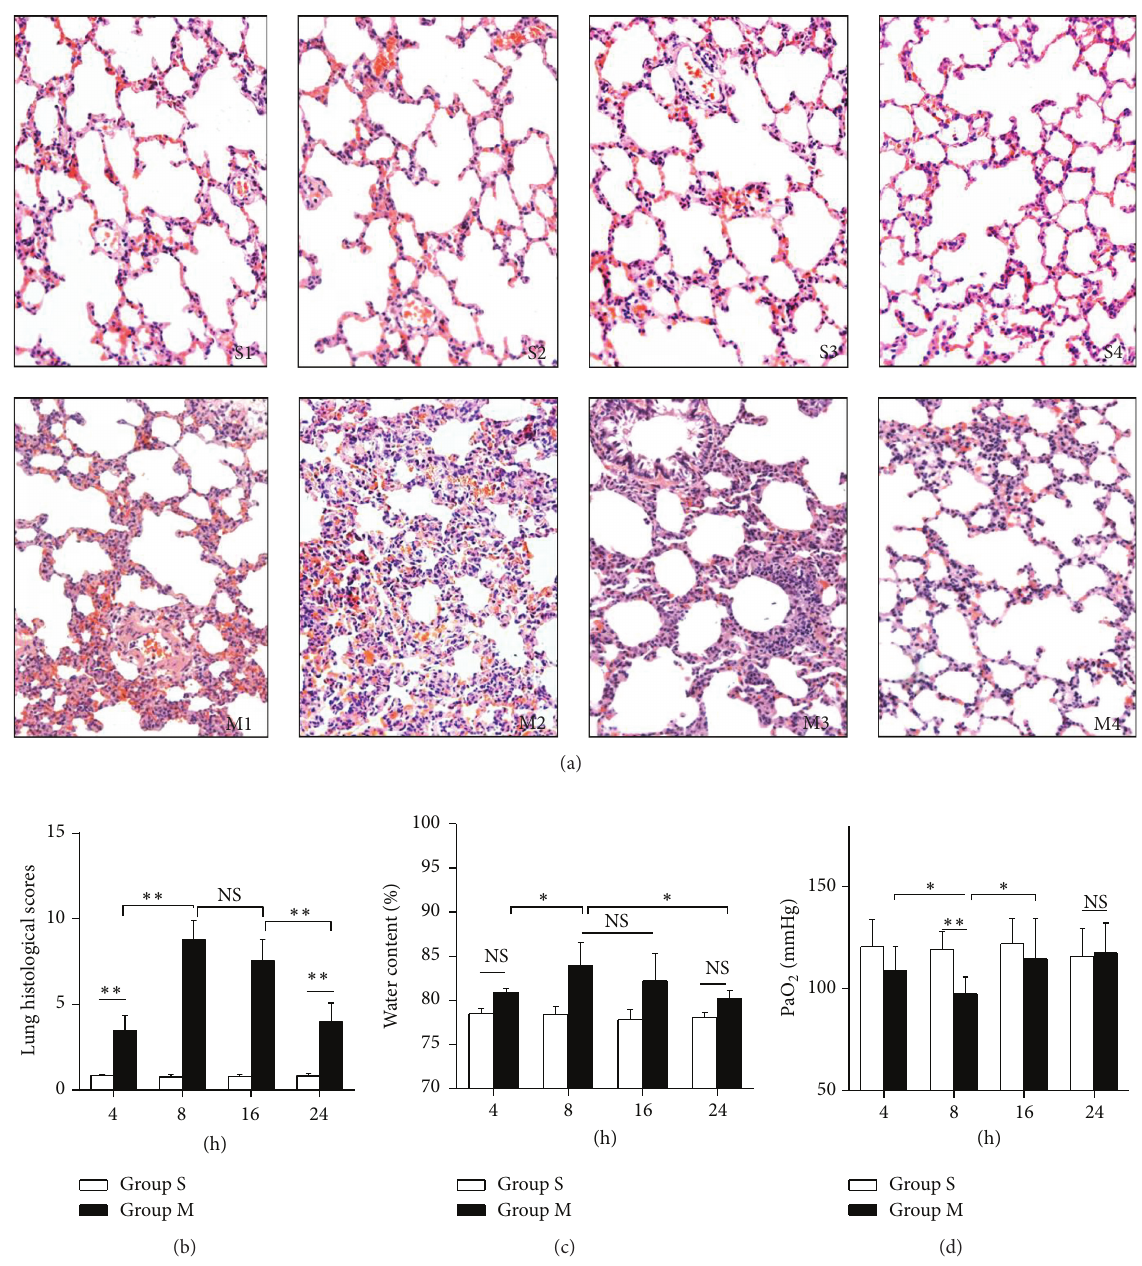
Figure 1: ALI induced by OALT in rat model. (a) Lung histology morphology. Lung sections were stained with hematoxylin and eosin (H&E) and visualized at 200x magnification. (b) Evaluation scores for lung histopathology analysis. (c) Water content of lung. (d) The arterial blood partial pressure of oxygen (PaO 2 ). Groups M1, M2, M3, and M4 represented as collecting samples at liver reperfusion after 4hrs, 8hrs, 16 hrs, and 24hrs, respectively. Values were expressed as mean ± SEM. 𝑛 = 4 per group. NS: no statistical significance; ∗ 𝑃 < 0.05 , ∗∗ 𝑃 < 0.01 , one-way ANOVA with Tukey